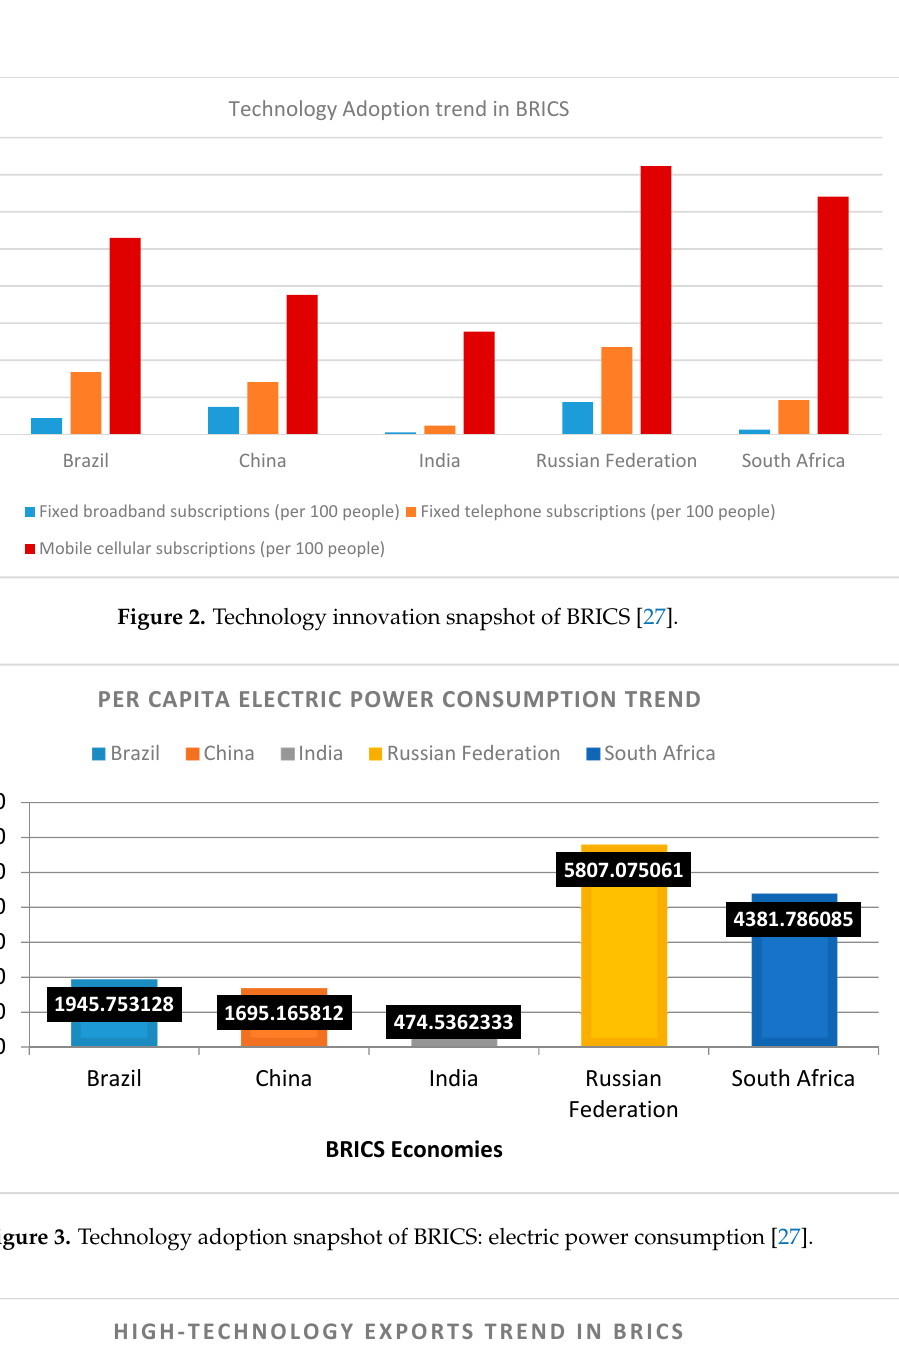
Figure 3. Technology adoption snapshot of BRICS: electric power consumption [27].